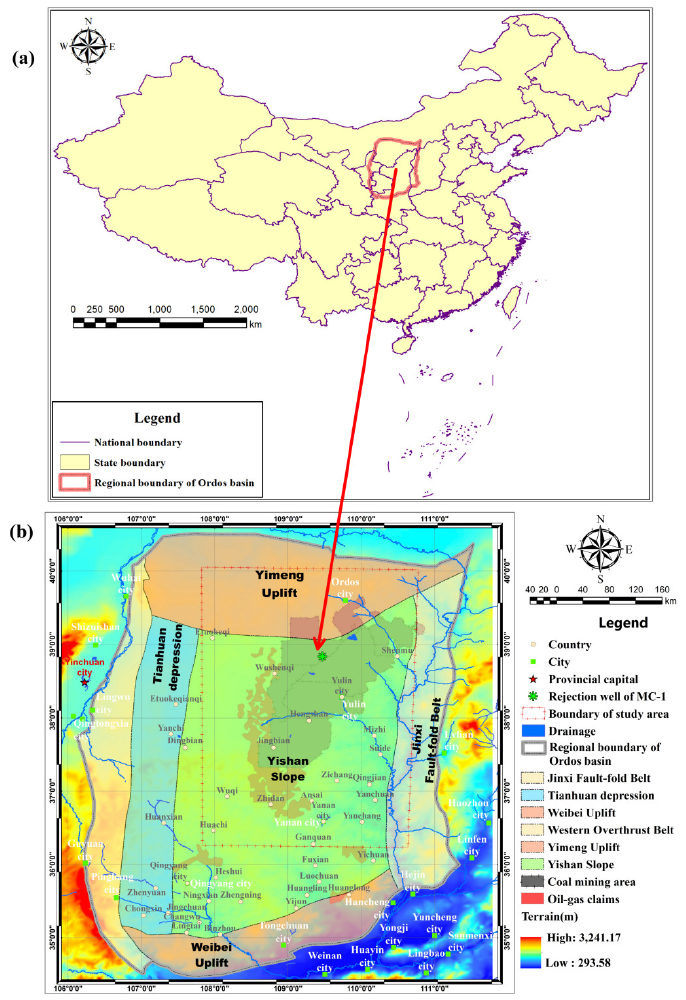
Figure 1. ( a ) The location for the Ordos Basin and the study area, ( b ) coal mining claims distribution and geological structure in the study area. LFm is the lower of Triassic and characterized with little porosity, low permeability [24] and high content of quartz (average 40.1%) and feldspar (average 31.1%). The lithol- ogy of LFm is interlayered with different thickness of purple mudstone, grey-white and flesh red sandstone [25]. Mine water from Jurassic coal measures [26] and its overlying aquifers is injected into LFm by high pressure pumps at surface, as shown in Figure 2.